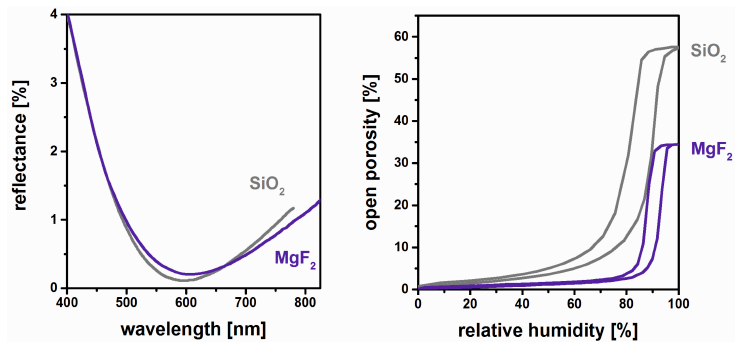
Figure 5. Reflectance ( left ) and open porosity as measured by Ellipsometric Porosimetry ( right ) of porous SiO 2 and MgF 2 coatings. Based on [41].